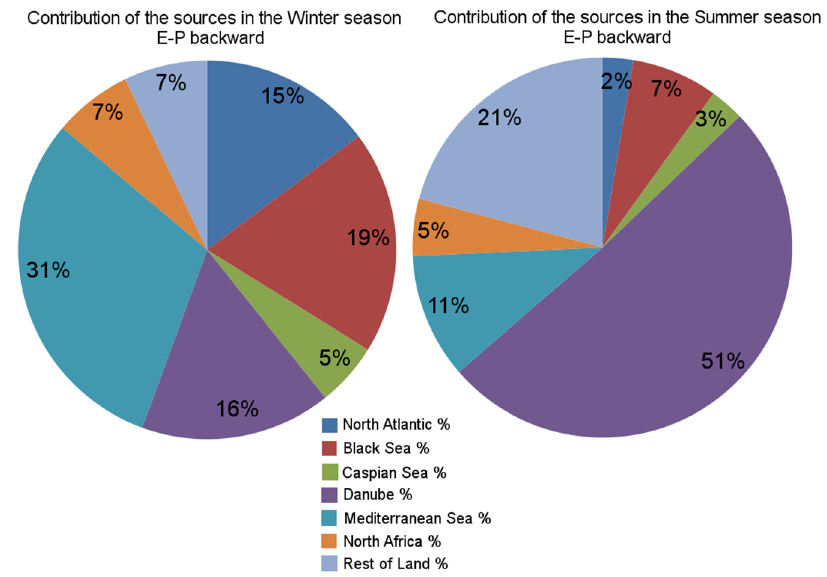
Figure 7. Moisture uptake over the sources obtained from E-P backward analysis for the DRB for winter and summer in percentage terms (%).